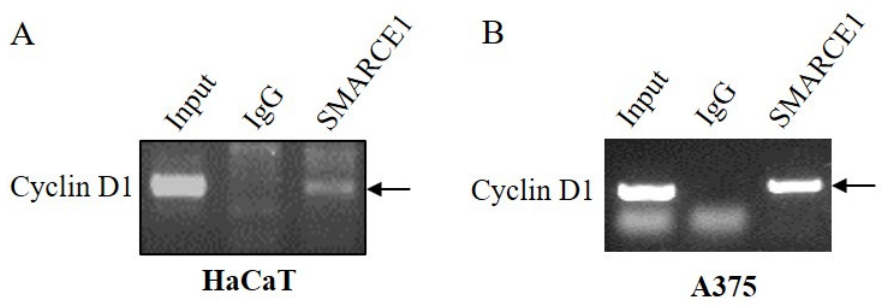
Figure 5. The binding between SMARCE1 and cyclin D1 pre-mRNA. The binding of SMARCE1 to pre-mRNA of cyclin D1 was detected by reverse transcription PCR (RIP) assay in HaCaT ( A ) and A375 ( B ) cells. Arrows indicated the cyclinD1 bond.